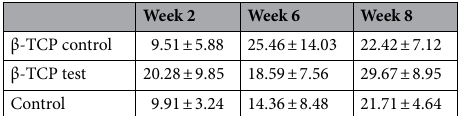
Table 5. Histologic new bone formation bone area/tissue area